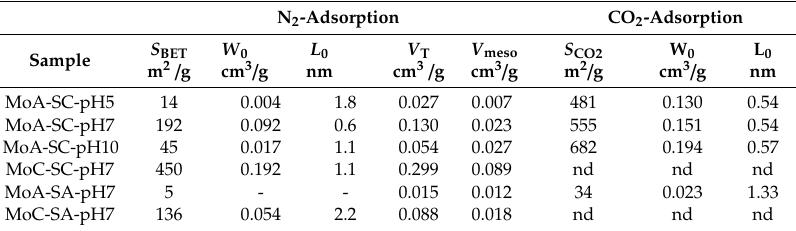
Table 2. Porous characteristics of metal-doped carbon